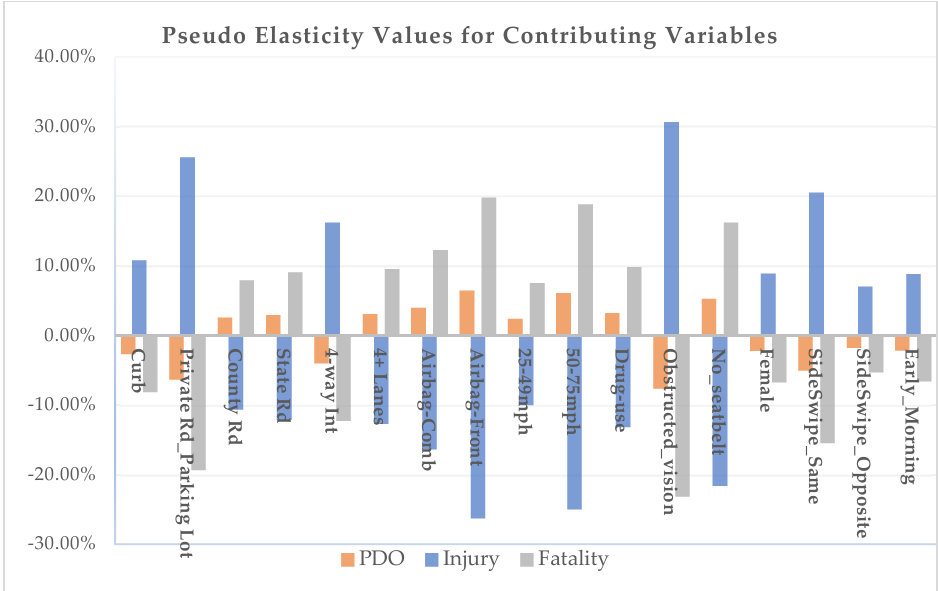
Figure 1. Marginal effects of factors contributing to large-truck WWD crash.